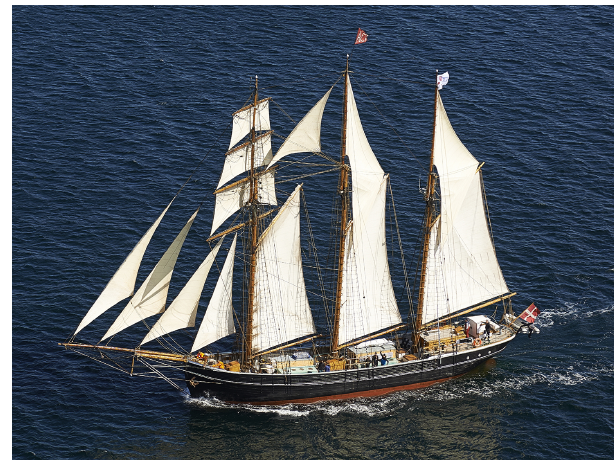
Figure 1. The three-masted wooden schooner SS ACTIV